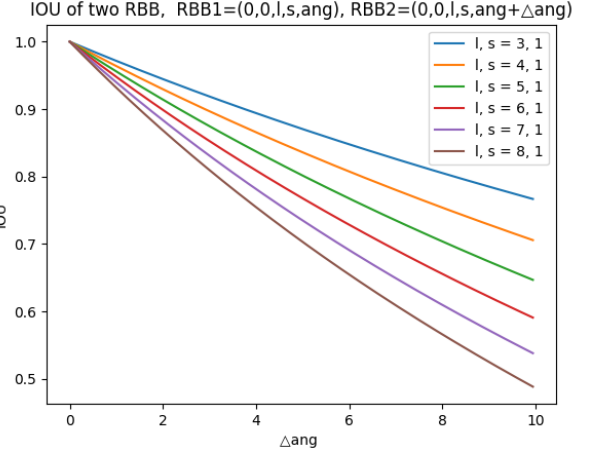
Figure 3. Relationship curves of the IOU and angle deviation for the angle-based